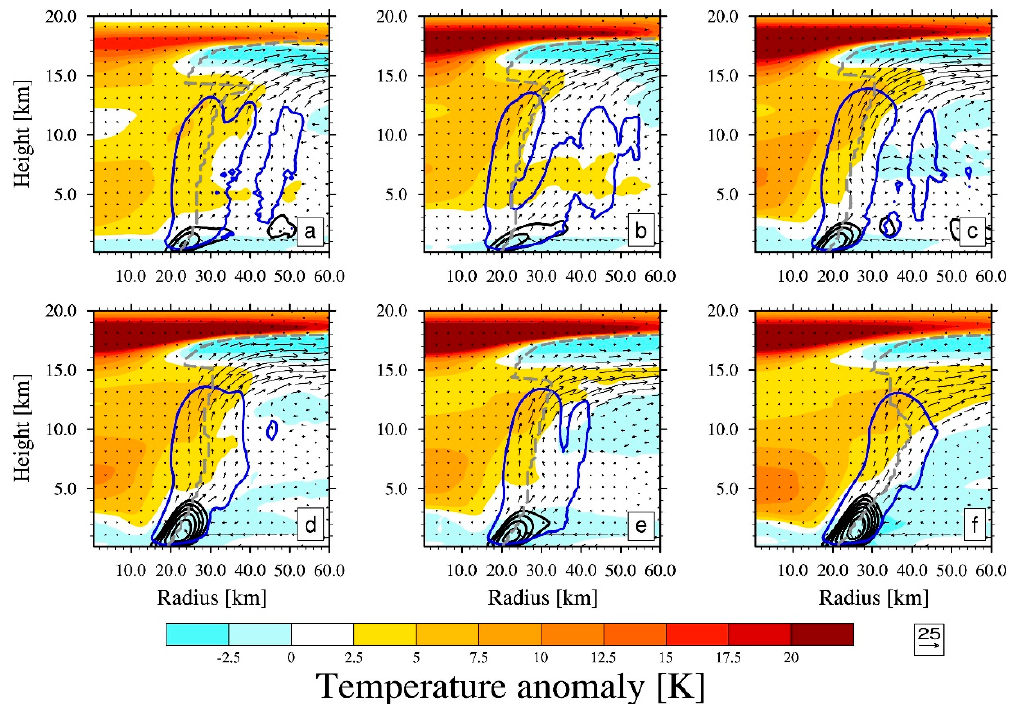
Figure 7. Radial and height cross-sections of the warm core structure in the CTL experiment. Times are at ( a ) t = 75 h, ( b ) t = 100 h, ( c ) t = 125 h, ( d ) t = 150 h, ( e ) t = 175 h, and ( f ) t = 200 h. The color shading indicates the temperature anomaly and the vectors shows wind. The blue contours, the black contours, and the gray lines show, respectively, the diabatic heating rate ( > 20 K h − 1 ) from microphysical processes, the degree of supergradient wind, and the radius of maximum winds at each height. The temperature anomaly here is defined as the deviation from the average temperature from the radii of 550 km to 650 km at each height.